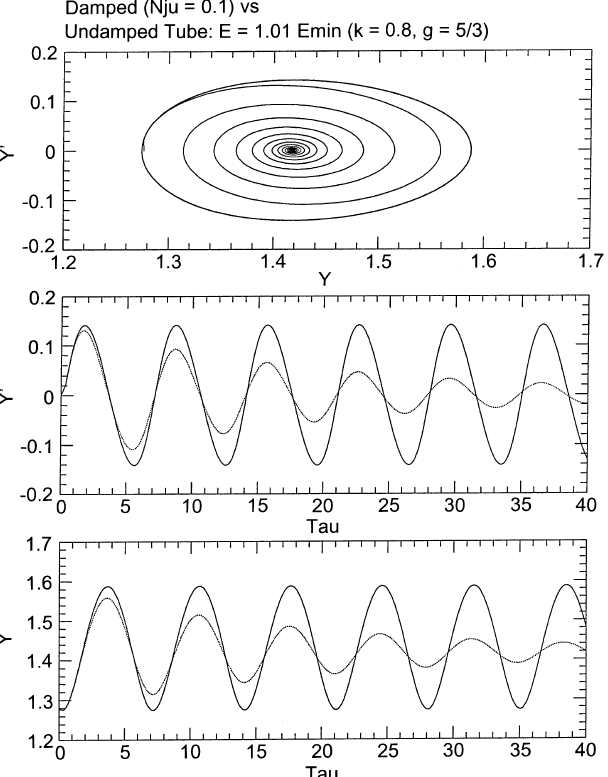
Fig. 10. Similar to Fig. 9 but this time with a much higher damping coefficient (cid:133) (cid:109) (cid:3) (cid:136) 0 : 6 (cid:134) in the same format as Fig. 8. The respective durations of one cycle can be read off from the marked positions of two successive maxima in the bottom panel